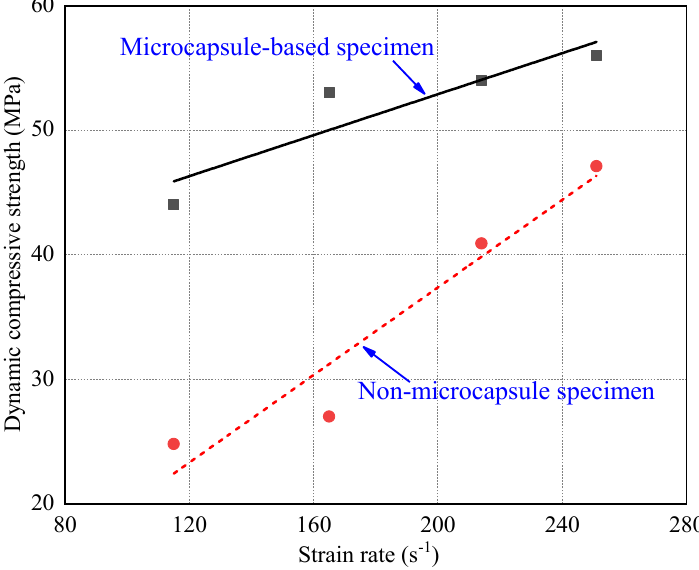
Figure 8. Relation between dynamic compressive strength and strain rate.